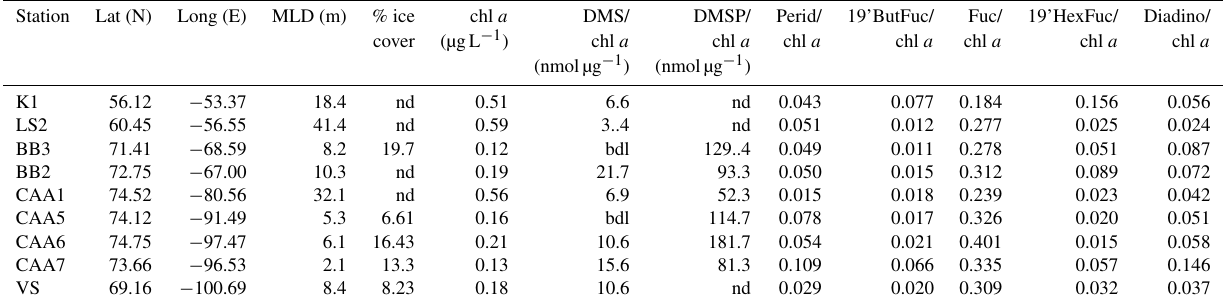
Table 2. Mixed layer depth (MLD), ice cover, HPLC pigment measurements (ratios of selected marker pigments to chl a ), DMS (MIMS) and DMSP (OSSCAR) measurements. Perid is peridinin, 19’ButFuc is 19’-butanoyloxyfucoxanthin, Fuc is Fucoxanthin, 19’HexFuc is 19’- hexanoyloxyfucoxanthin, and Diadino is Diadinoxanthin. nd means no data. bdl means below detection limit. Station Lat (N)